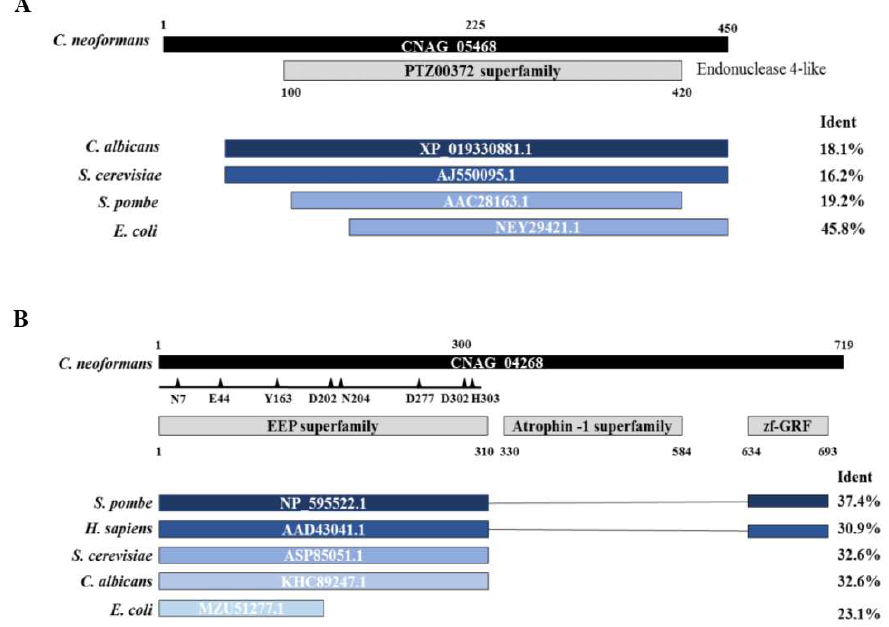
Figure 1. Comparative analysis of Apn deduced amino acid sequences. APN1 -like (CNAG_05468) and APN2 -like (CNAG_04268) gene sequences from C. neoformans were used as query for Blastp analyses. ( A ) Alignment results of Apn1 amino acid sequences from C. albicans , S. pombe , S. cerevisiae and E. coli , highlighting the cover and identity with the C. neoformans Apn1-like amino acid sequence. ( B ) Alignment results of Apn2 sequences from S. pombe , H. sapiens , C. albicans , S. cerevisiae and E. coli , highlighting the cover and identity with the C. neoformans Apn2-like deduced amino acid sequences. NCBI accession numbers are depicted in each protein representation. Triangles represent key-amino acids for the catalytic sites; Ident: percentage of amino acid identity provided by Blastp analysis on NCBI. EEP: exonuclease-endonuclease-phos- phatase. zf-GRF: zinc finger